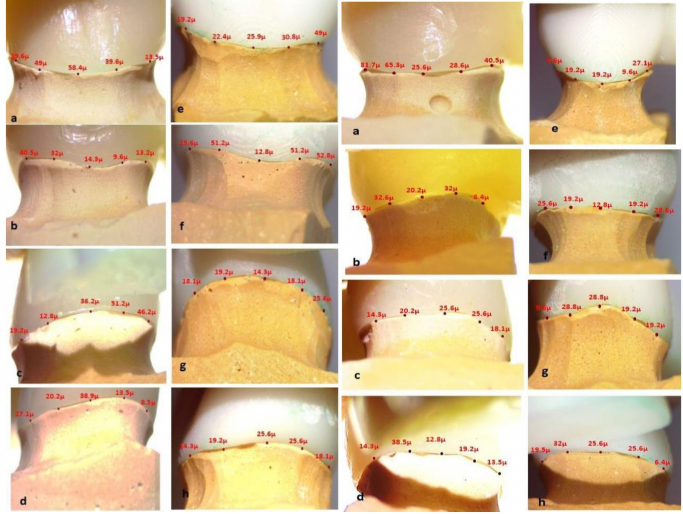
Figure 17. 3D printed provisional restoration (molar and premolar) at different surfaces: ( a – d ) milled and ( e – h ) 3D printed (buccal, lingual, mesial, and